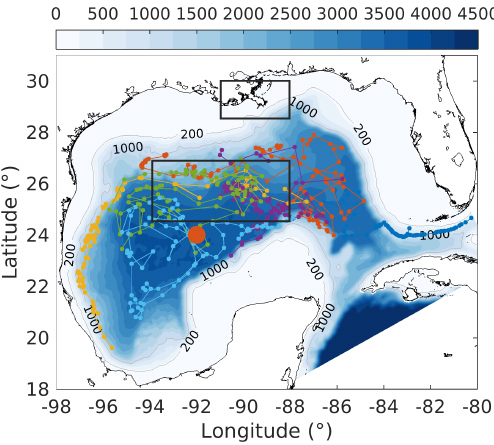
Figure 1. Model bathymetry (unit:m) with trajectories of six bio- optical floats (small colored dots and lines) which were operated in the Gulf of Mexico from 2011 to 2015. The location of the 1D model is denoted by the large orange dot. The north and south black boxes represent the Mississippi Delta and the central gulf, respec- tively, to show comparisons of surface chlorophyll in Fig.